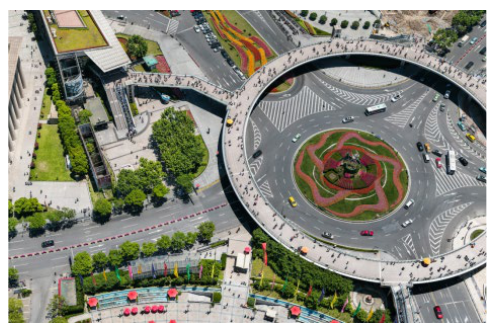
Figure 2. Image 1 Original Input Image